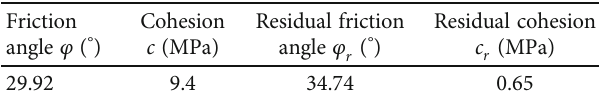
Table 2: Strength parameters of